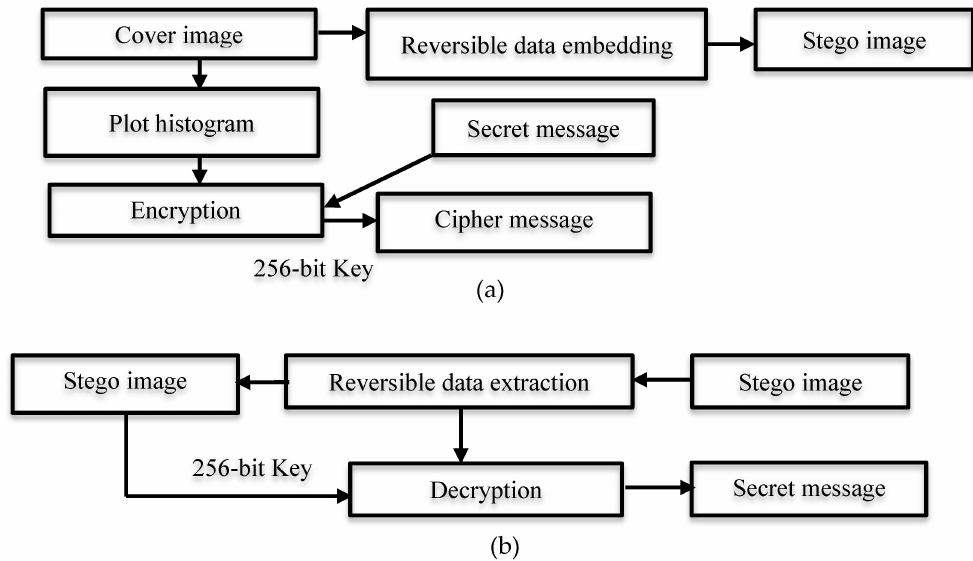
Figure 5. ( a ) Block diagram for data embedding, and ( b ) block diagram for data extraction.